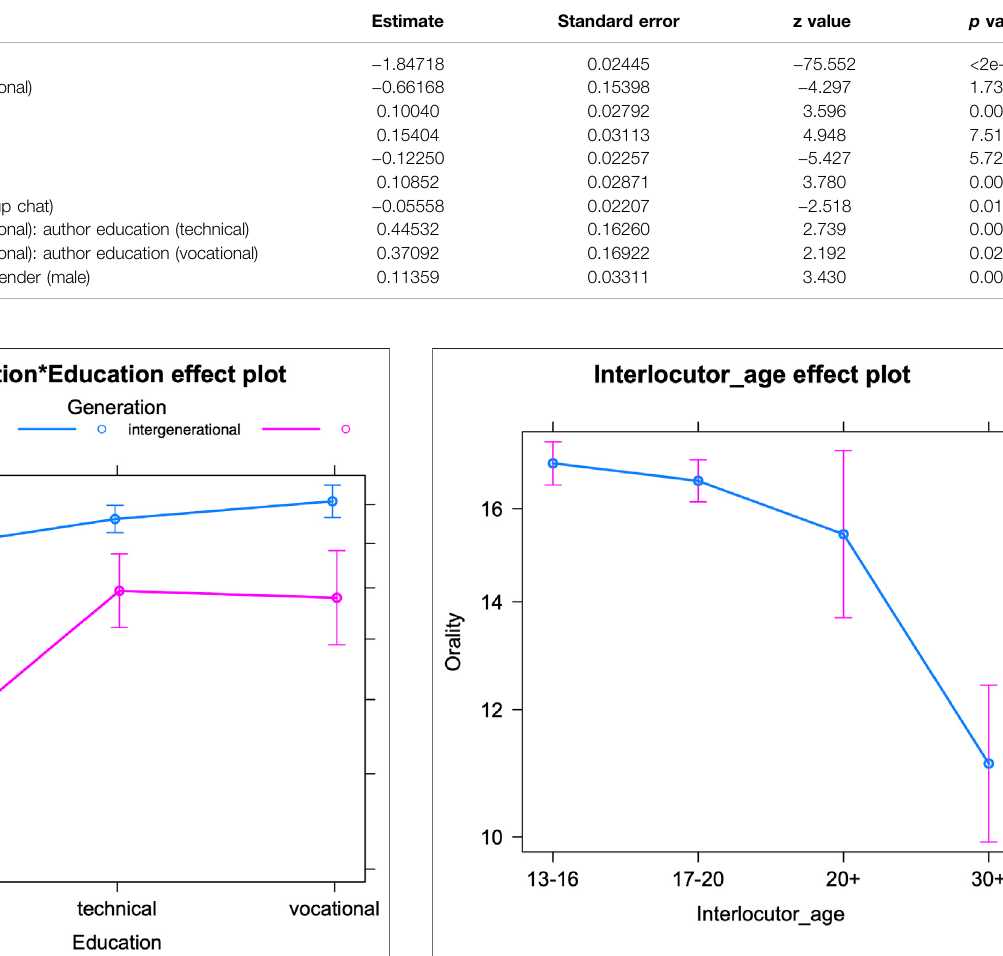
FIGURE 4 | Oral markers per interlocutor age (predicted counts per 100 tokens).